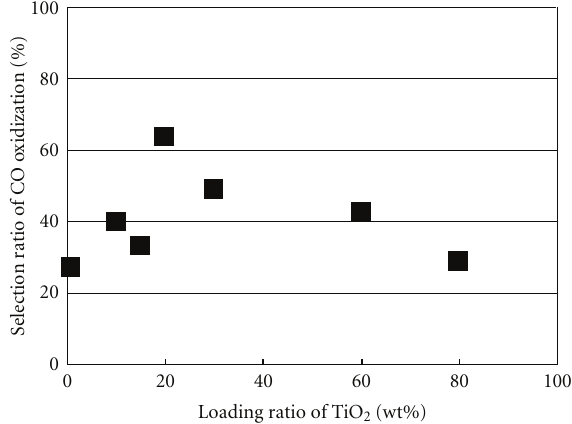
Figure 8: Comparison of selection ratio of CO oxidization among di ff erent loading ratio of TiO 2 .